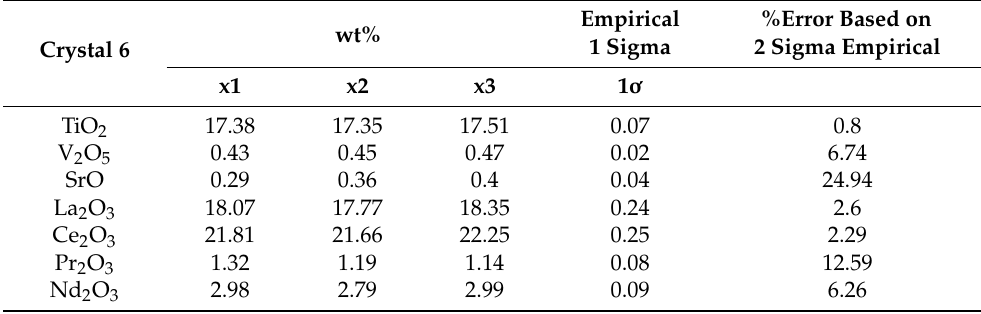
Table 5. Chemical compositions for three consecutive analyses (x1, x2, x3) on two different chevkinite crystals (crystal 6 and crystal 7) for estimation of